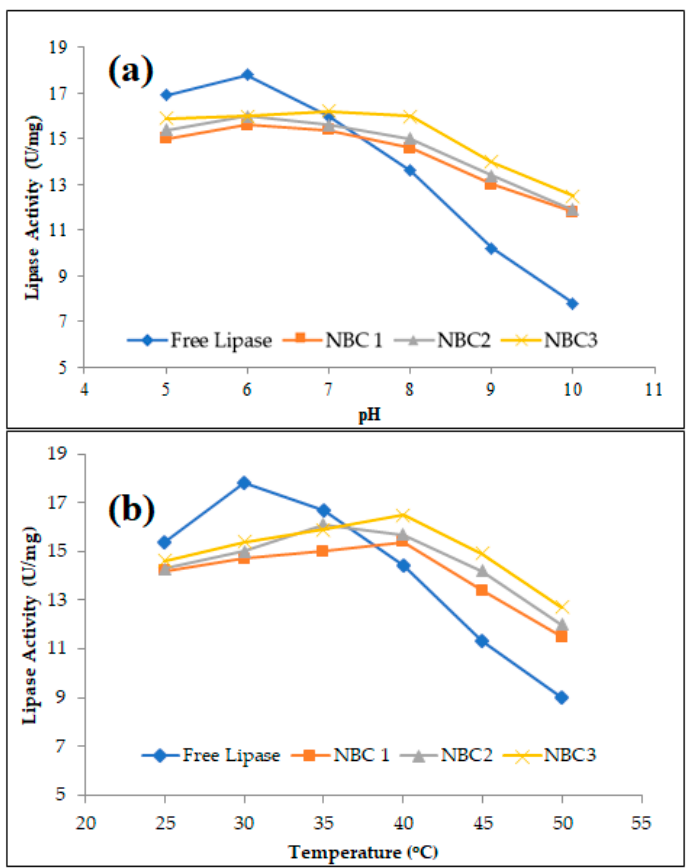
Figure 6. Impact of ( a ) pH ( b ) temperature on enzyme activity of free and immobilized A. niger lipase.